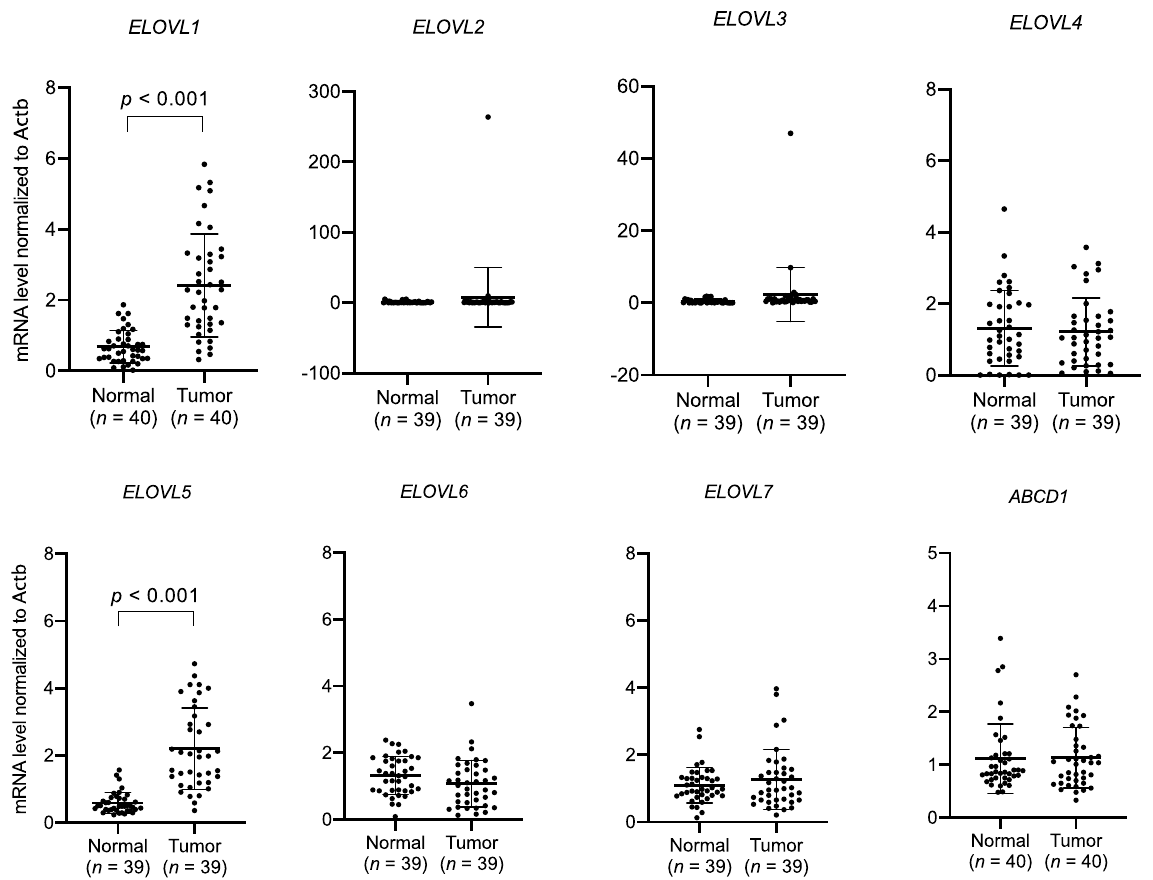
Figure 4. ELOVL1 and ELOVL5 were highly expressed in colorectal cancer (CRC) tissues. The mRNA level of ELOVL1 – ELOVL7 and ABCD1 in CRC and adjacent normal tissues. Data represent the mean ± SD. Statistical analysis was performed using the two-tailed paired t